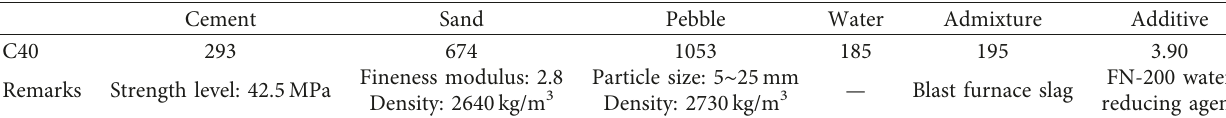
Table 2: C40 Concrete mix ratio kg/m 3 .